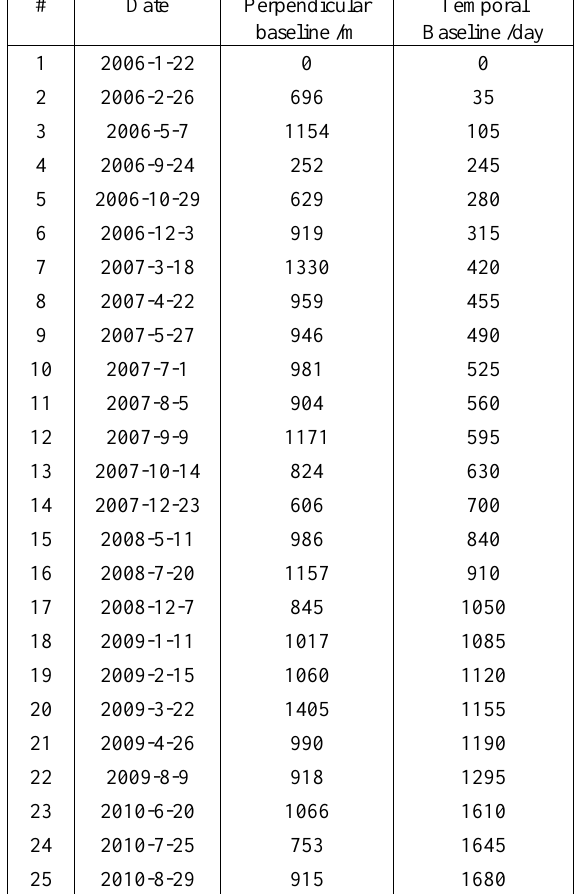
Table 1. List of the perpendicular and temporal baselines of 25 ENVISAT ASAR